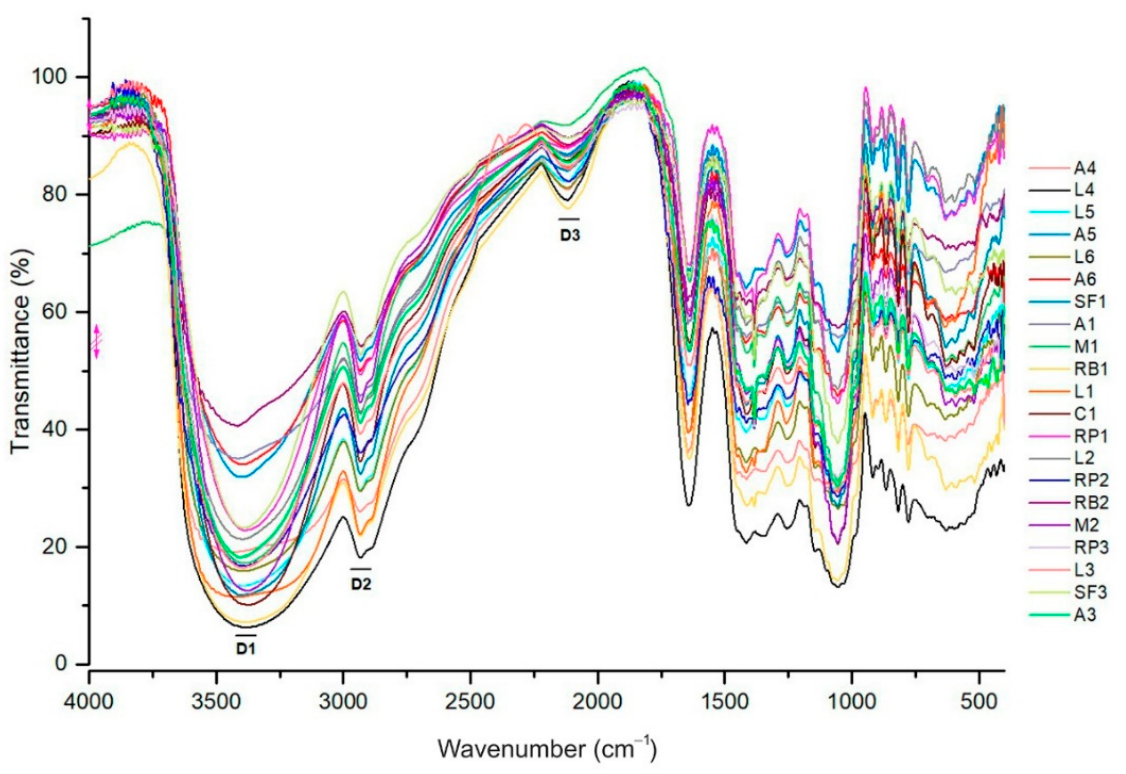
Figure 3. FTIR spectra of all studied honey samples in the spectral region from 4000 to 400 cm − 1 .